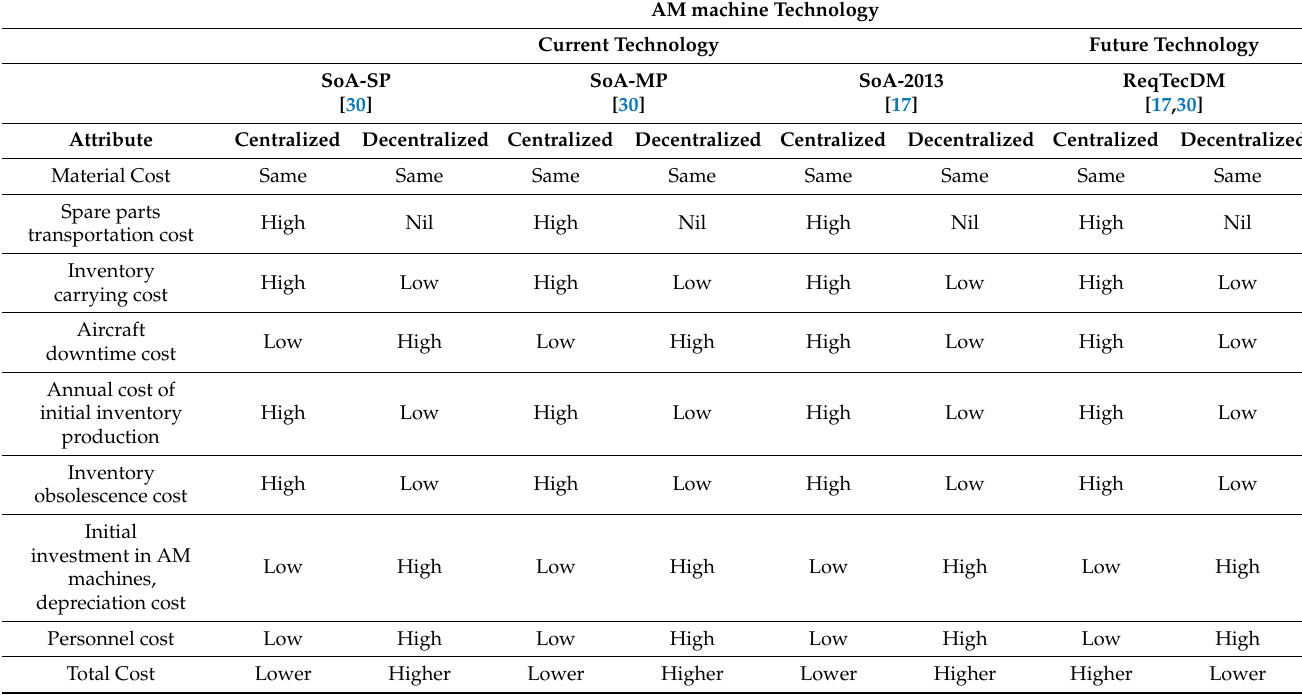
Table 7. Cost Comparisons of Supply Chain Scenarios among AM Technologies.